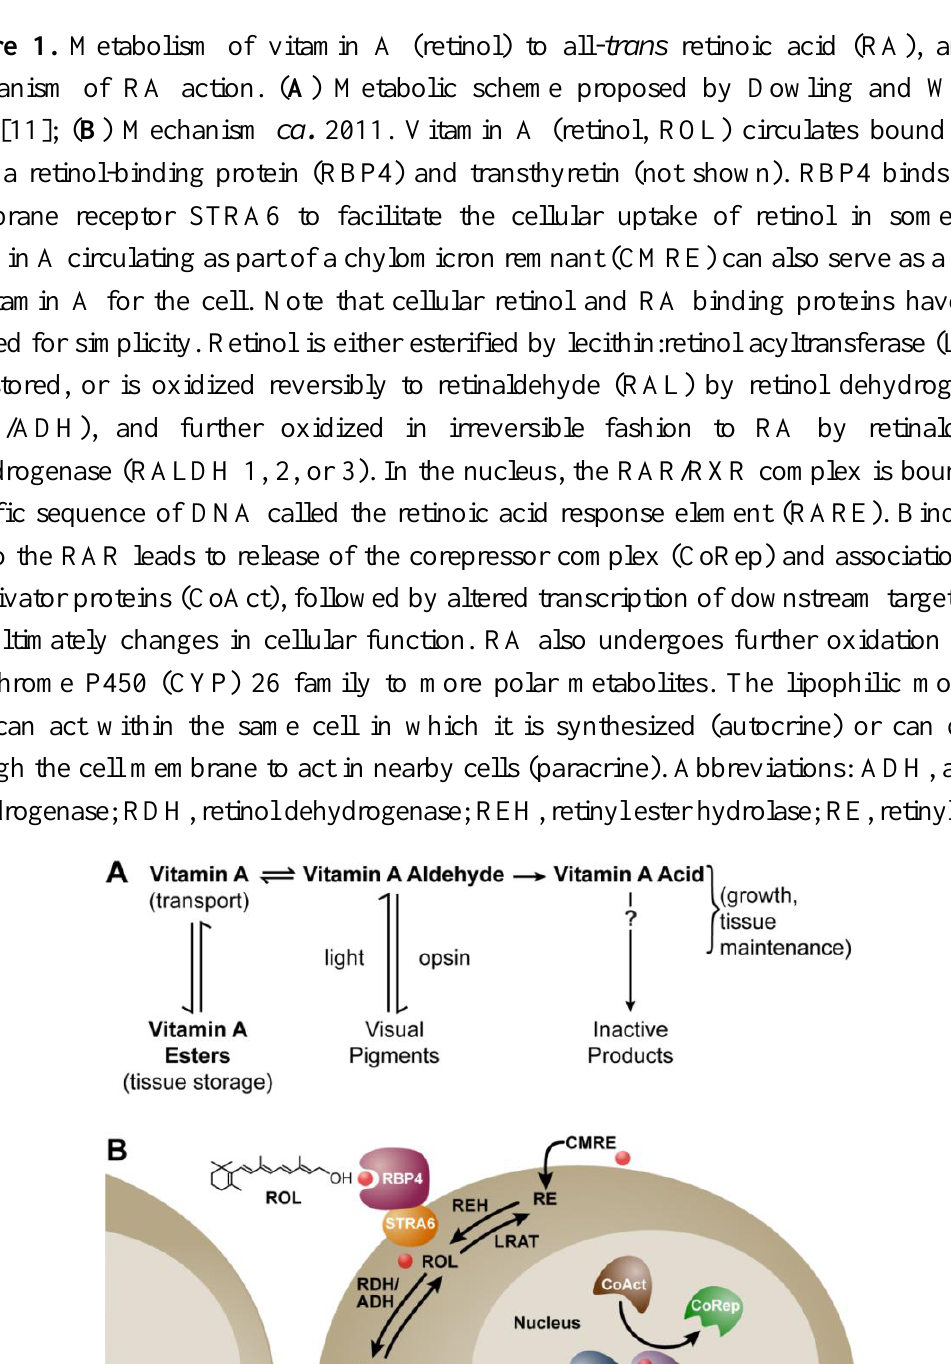
Figure 1. Metabolism of vitamin A (retinol) to all- trans retinoic acid (RA), and